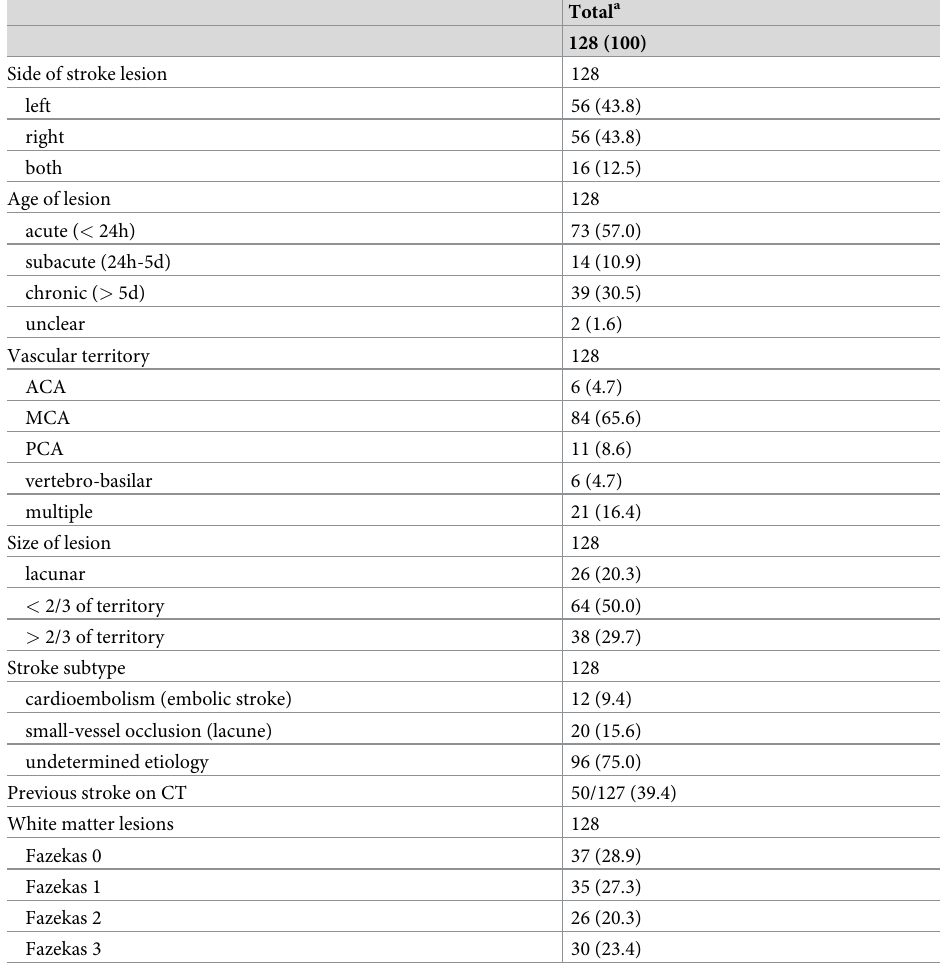
Table 2. Imaging characteristics of patients with ischemic